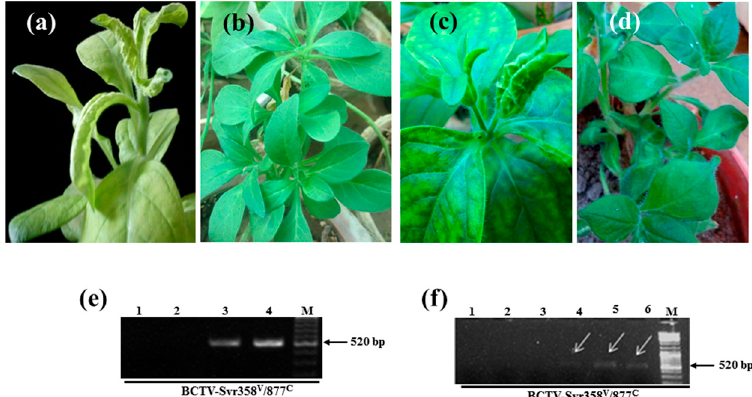
Figure 4. Detection of BCTV-Svr in agroinfected petunia plants and their developed seeds. ( a ) Severe curly top symptoms in a BCTV-Svr-agroinoculated plant of local cultivar; ( b ) curly top free (healthy) plants of local cultivar; ( c ) a BCTV-Svr-agroinoculated plant of PCSP cultivar showing interveinal chlorosis, leaf curling and vein swelling; ( d ) healthy plants of PCSP cultivar; ( e , f ) agarose gel electrophoresis analysis of IC-PCR products using a BCTV antibody and the BCTV-Svr358 V /877 C primer pair (Table 1); ( e ) lanes 1 and 2, extracts of leaf tissue of healthy plants of PCSP cultivars as negative controls; lanes 3 and 4, extracts of leaf tissue of BCTV-Svr-agroinoculated plants of local and PCSP cultivars, respectively; ( f ) lanes 1–3, extracts of seeds of healthy plants of local cultivar as negative controls; lanes 4 and 5 extracts of seeds of BCTV-Svr-agroinoculated plants of local cultivar; lane 6, extract of seeds of BCTV-Svr-agroinoculated plants of PCSP cultivar. M = Marker (DNA ladder mix, Fermentas).